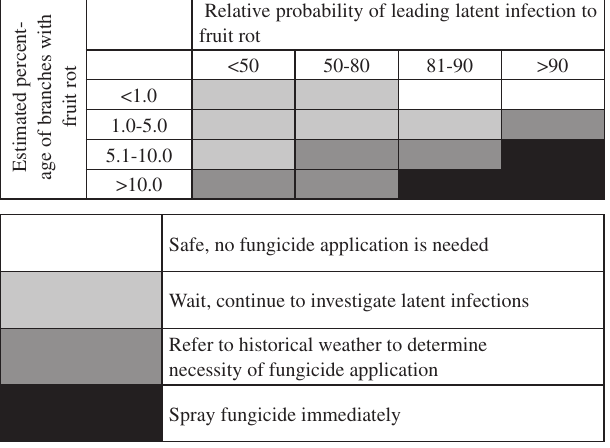
Figure 2 Diagram of decision process used in the decision support model for fungicide application to reduce risk of prune fruit rot caused by Monilinia fructicola (adapted from Luo & Michailides ,